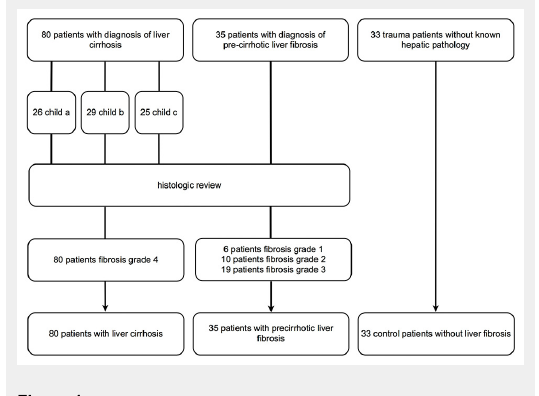
Patient population. Abdominal computed tomography scans of 148 patients were retrospectively analysed. Included were 80 patients with liver cirrhosis, 35 patients with earlier liver fibrosis and 33 control patients without known liver disease.